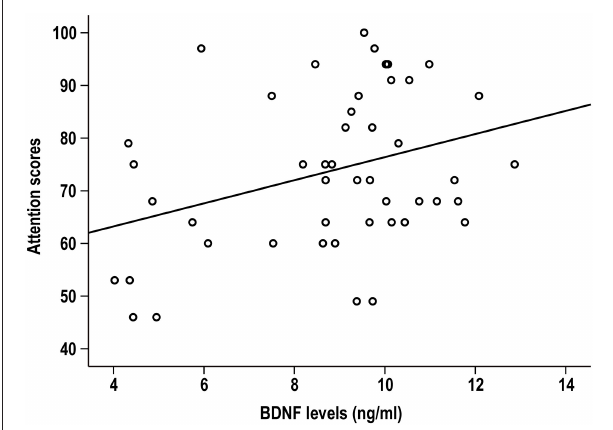
FIGURE 1 | Serum BDNF was positively associated with the attention index in patients with late-life schizophrenia ( r = 0.338, p = 0.019).